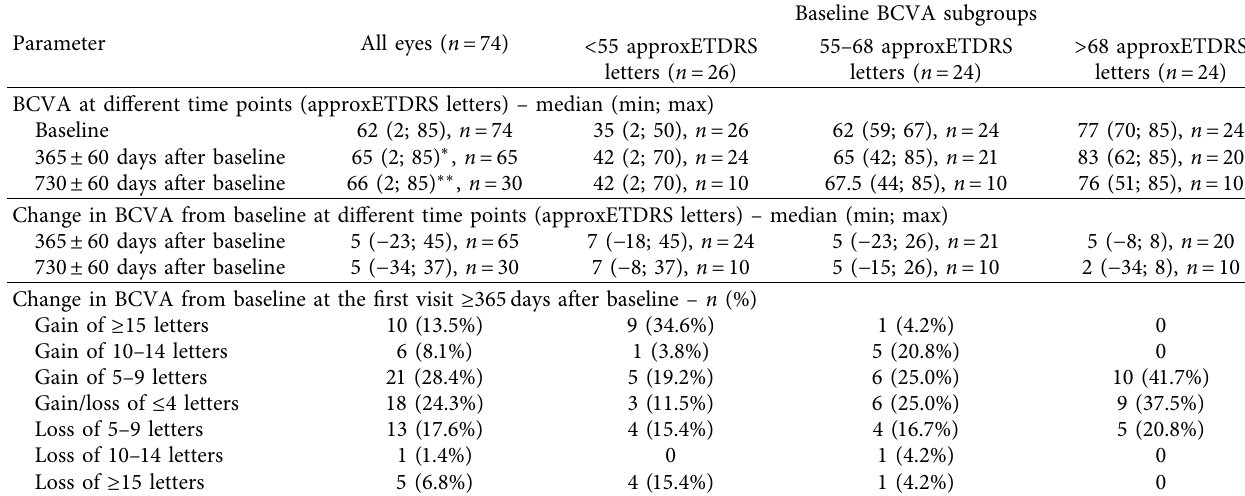
Table 2: BCVA outcomes among all eyes and within baseline BCVA subgroups.